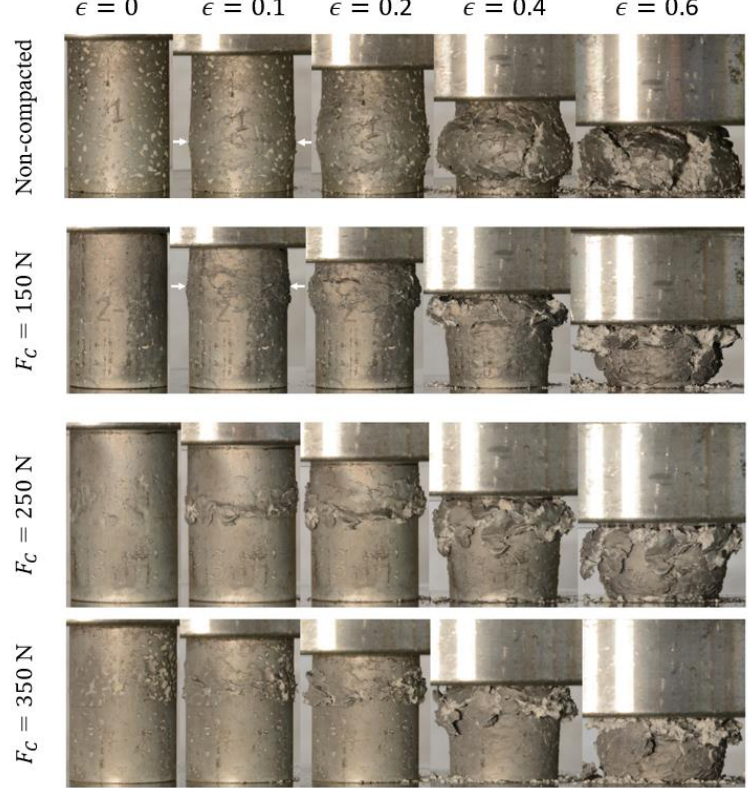
Figure 7. Deformation mechanism of samples under compression .